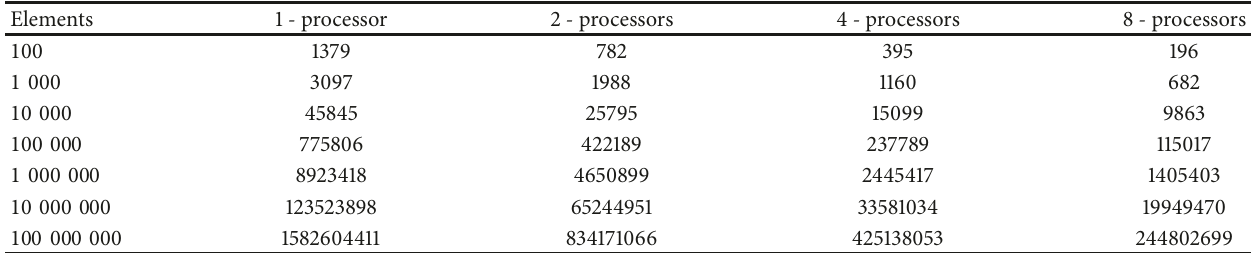
Table 2: Average benchmark sorting operations for 100 samples in [ti].